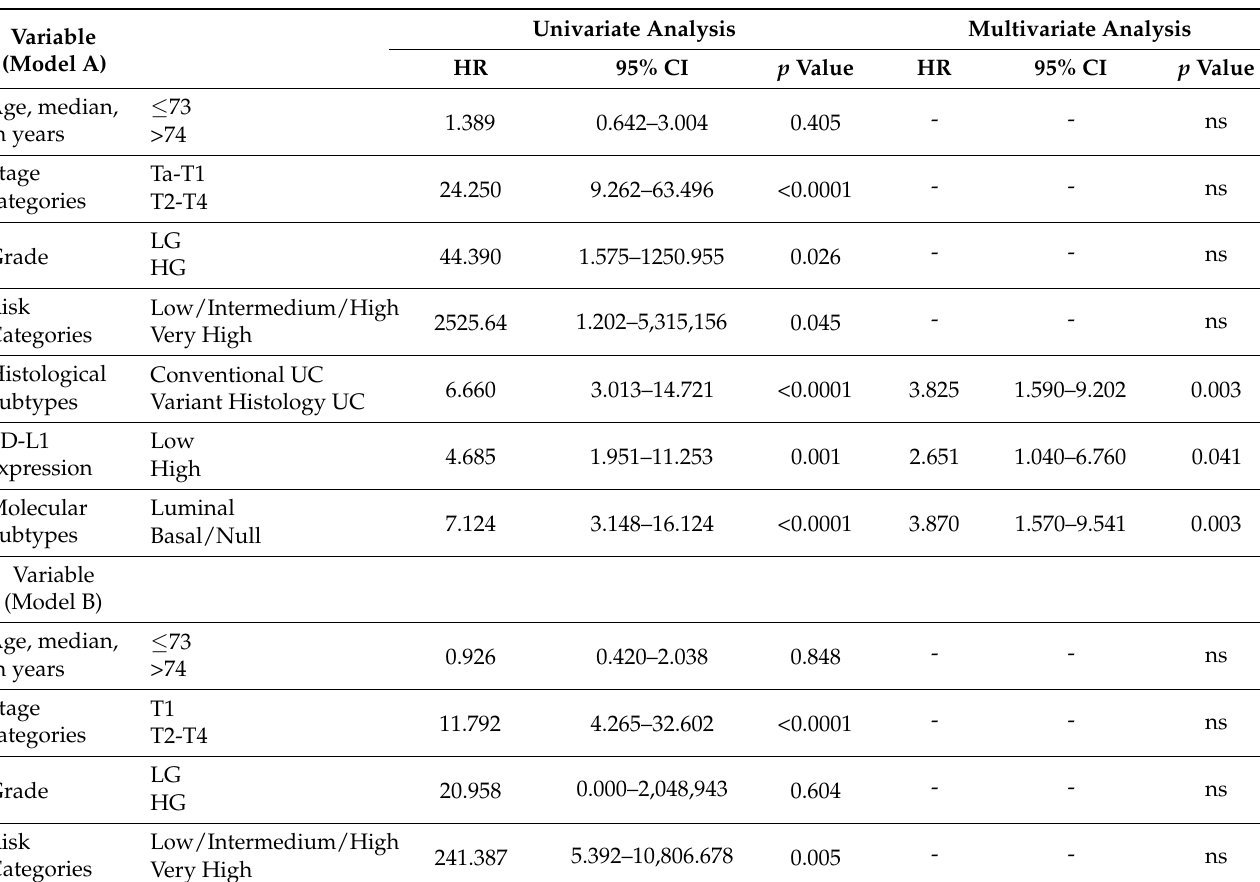
Table 4. Univariate and multivariate analysis of clinic-pathological parameters related to cancer-specific survival prediction in the current